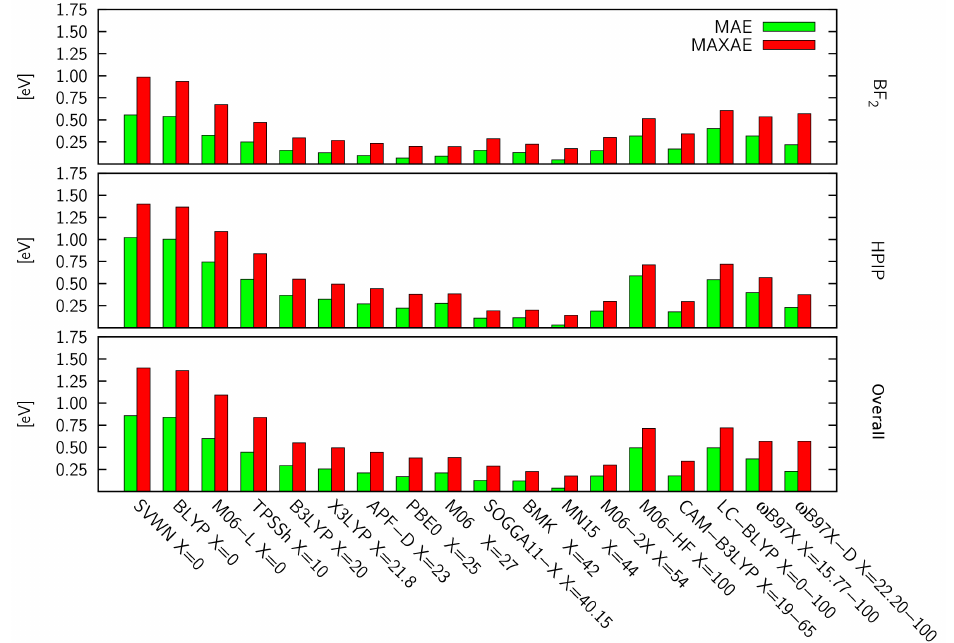
Figure 2. DFA absolute errors established for the excitation energy, determined with respect to